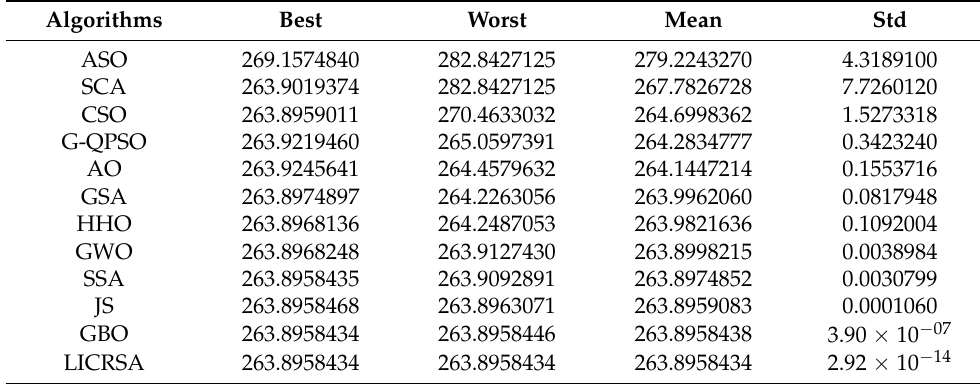
Table 14. Statistics of 20 independent operations of three-bar truss design.